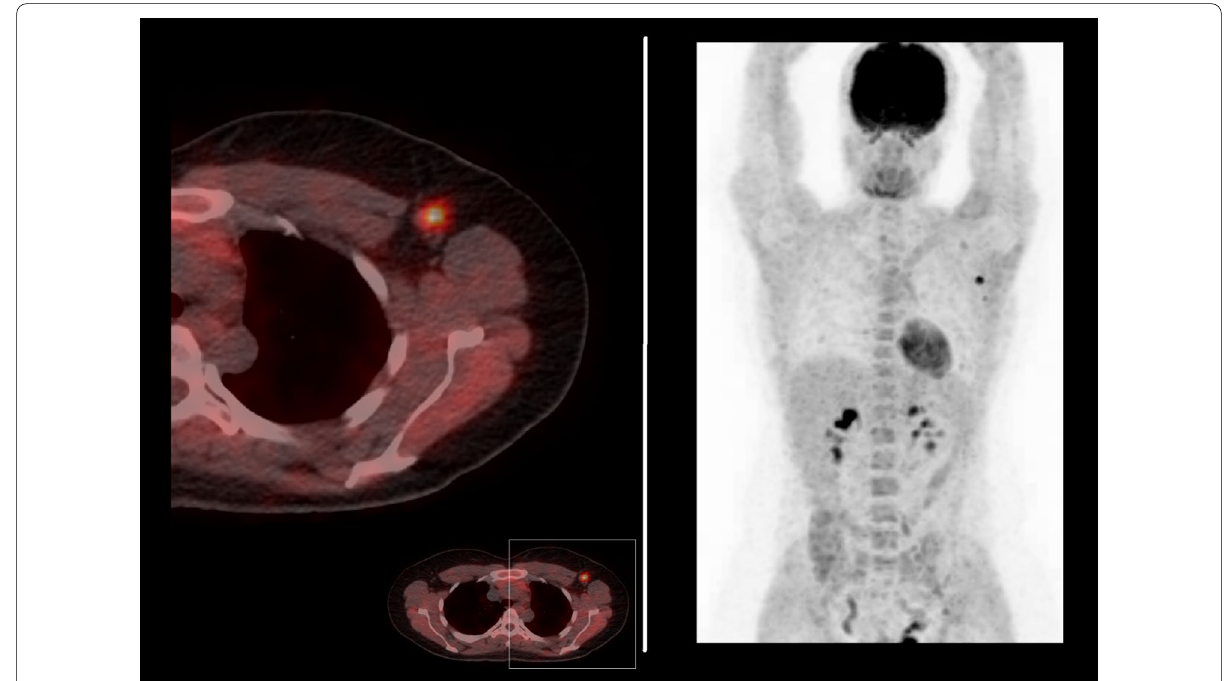
Fig. 1 Patient example. Example of a patient with a 22-mm HER2-positive invasive carcinoma of no special type in her left breast. An axial 18 F-FDG PET/CT exam of the left axilla shows the most FDG-avid axillary lymph node with an SUVmax of 7.37. Following completion NST, this patient had residual axillary